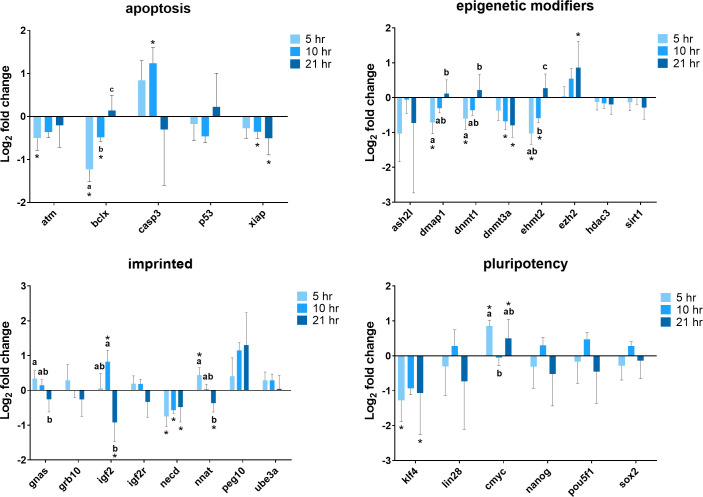
Summary of relative gene expression levels in fibroblast cells of Chamber I exposed 380 nA of electrical biostimulation for 5, 10, and 21 hours.Graphs depicting the average log2 fold change values of every gene for each of the functional gene categories tested by qPCR using the BioMark system from Fluidigm. In each of these graphs, error bars reflect the standard error of the mean log2 fold change values calculated for four replicate reactions. * = significantly different from the control (the cells in Chamber III of the 5, 10, and 21 hours experiment, respectively). a,b,c = within a panel (gene category), different superscripts denote statistically significant differences in log2 fold change values between samples (P < 0.05).